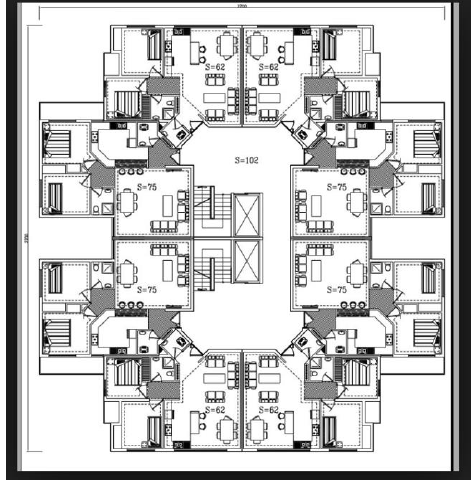
Figure 6 : Type of plan for high rise Mehr housing project in Pardis city (URL 5). In this plan there are two type of units. One of them is 75 square meter. The other one is